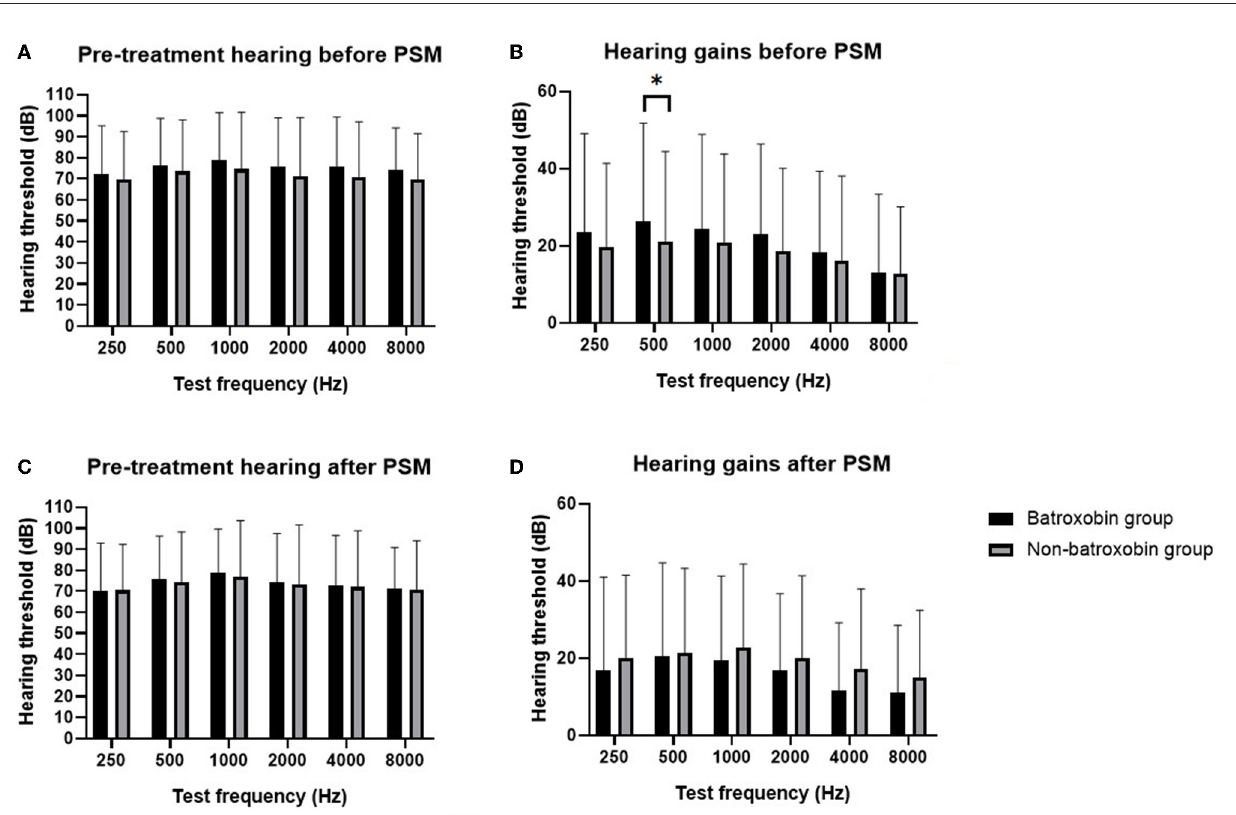
FIGURE2 Comparison of pre-treatment hearing and hearing gains between the batroxobin group and the non-batroxobin group in the sensitivity analysis. (A) Pre-treatment hearing level of batroxobin group and non-batroxobin group before PSM. (B) Hearing gains of batroxobin group and non-batroxobin group before PSM. (C) Pre-treatment hearing level of batroxobin group and non-batroxobin group after PSM. (D) Hearing gains of batroxobin group and non-batroxobin group after PSM. The black bar represents the batroxobin group and the gray bar represents the non-batroxobin group, * stands for a p -value of <